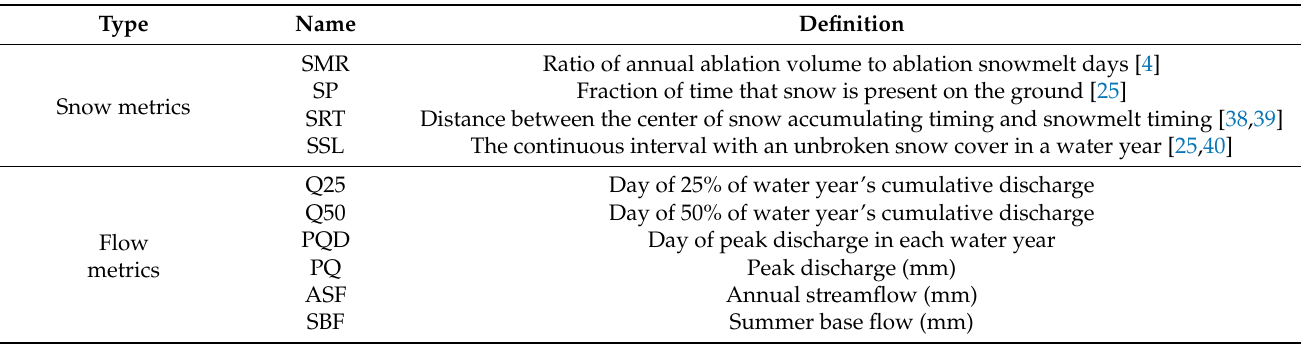
Table 1. Definition of snow and flow